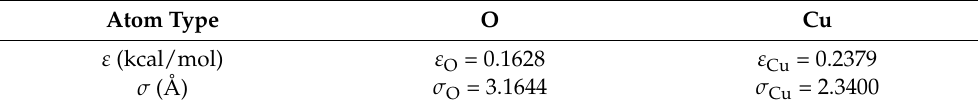
Table 2. Interaction parameters for oxygen and copper atoms